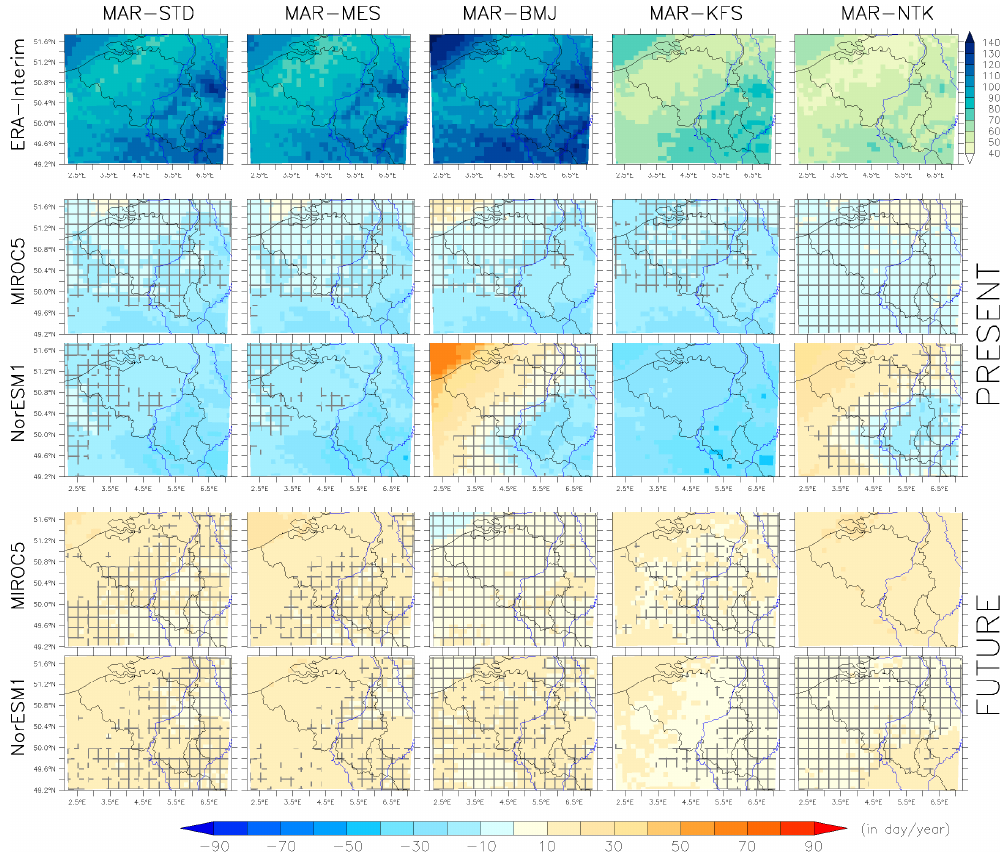
Figure 5. Same as Figure 2, but for the annual mean number of dry days (days without precipitation) in days/year.